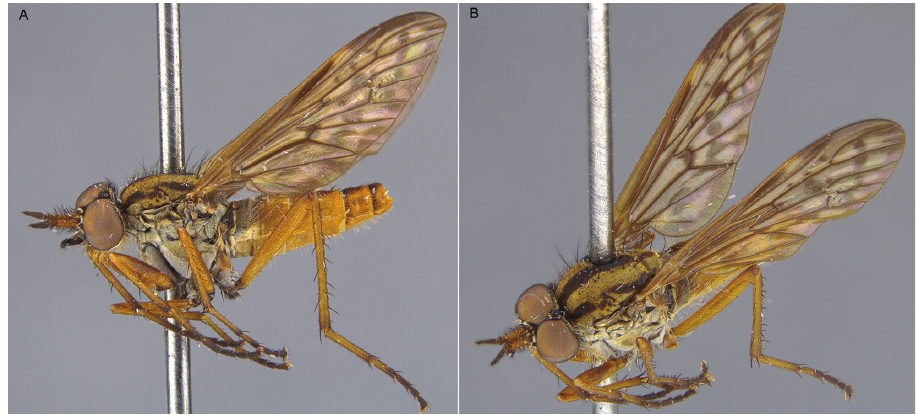
Figure 24. Zelothrix yeatesi sp. n.: A Male lateral view B same, oblique view (terminalia removed).